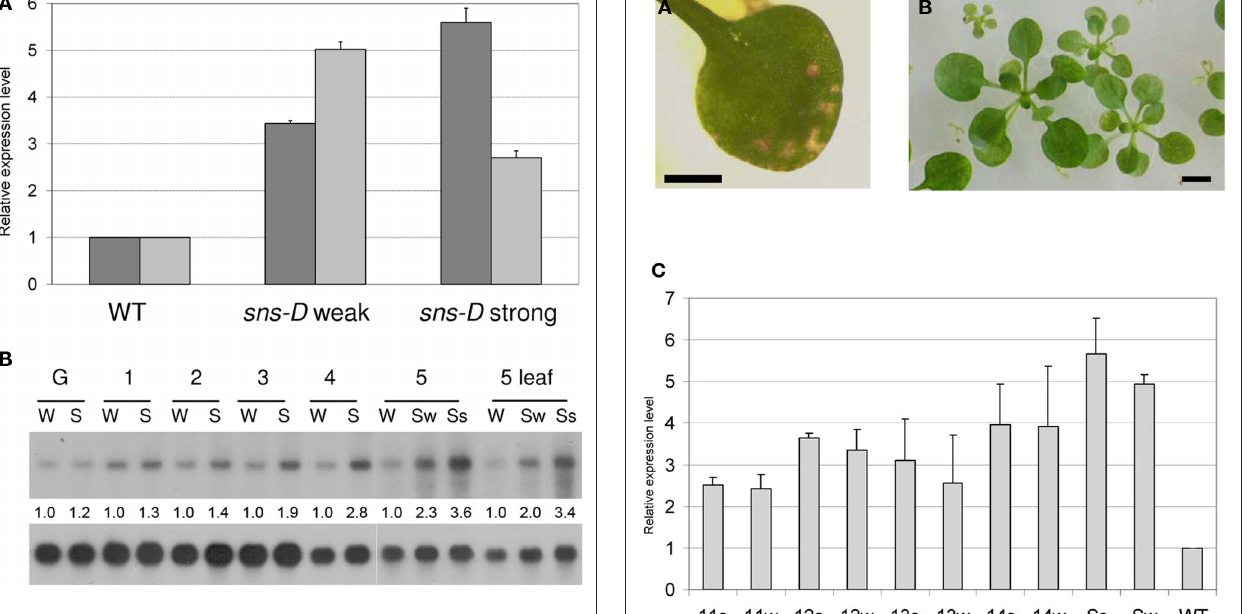
FIgURe 11 | expression levels of genes flanking the T-DNA/vector insert. (A) Relative expression levels of At1g13020 (dark gray bars) and At1g21550 (light gray bars) in wild-type plants (WT) and in sns-D mutants with weak and strong phenotypes as determined via Q-RT-PCR. The expression level in the wild-type was set on 1 and the SD in the mutants was indicated by error bars. (B) Northern blot analysis of At1g13020 in the wild-type (W) and the sns-D mutant (S) at different growth stages. G, just germinated; 1, 1 week after germination; 2, 2 weeks after germination; 3, 3 weeks after germination; 4, 4 weeks after germination; 5, 5 weeks after germination; Sw, sns-D plants with weak phenotype; Ss, sns-D plants with strong phenotype. Loading of RNA was determined by quantification of the bands after hybridization with At4g38740 (cyclophilin). Relative expression of At1g13020 in the mutant plants was shown for each developmental stage. The expression in the wild-type was set on 1.